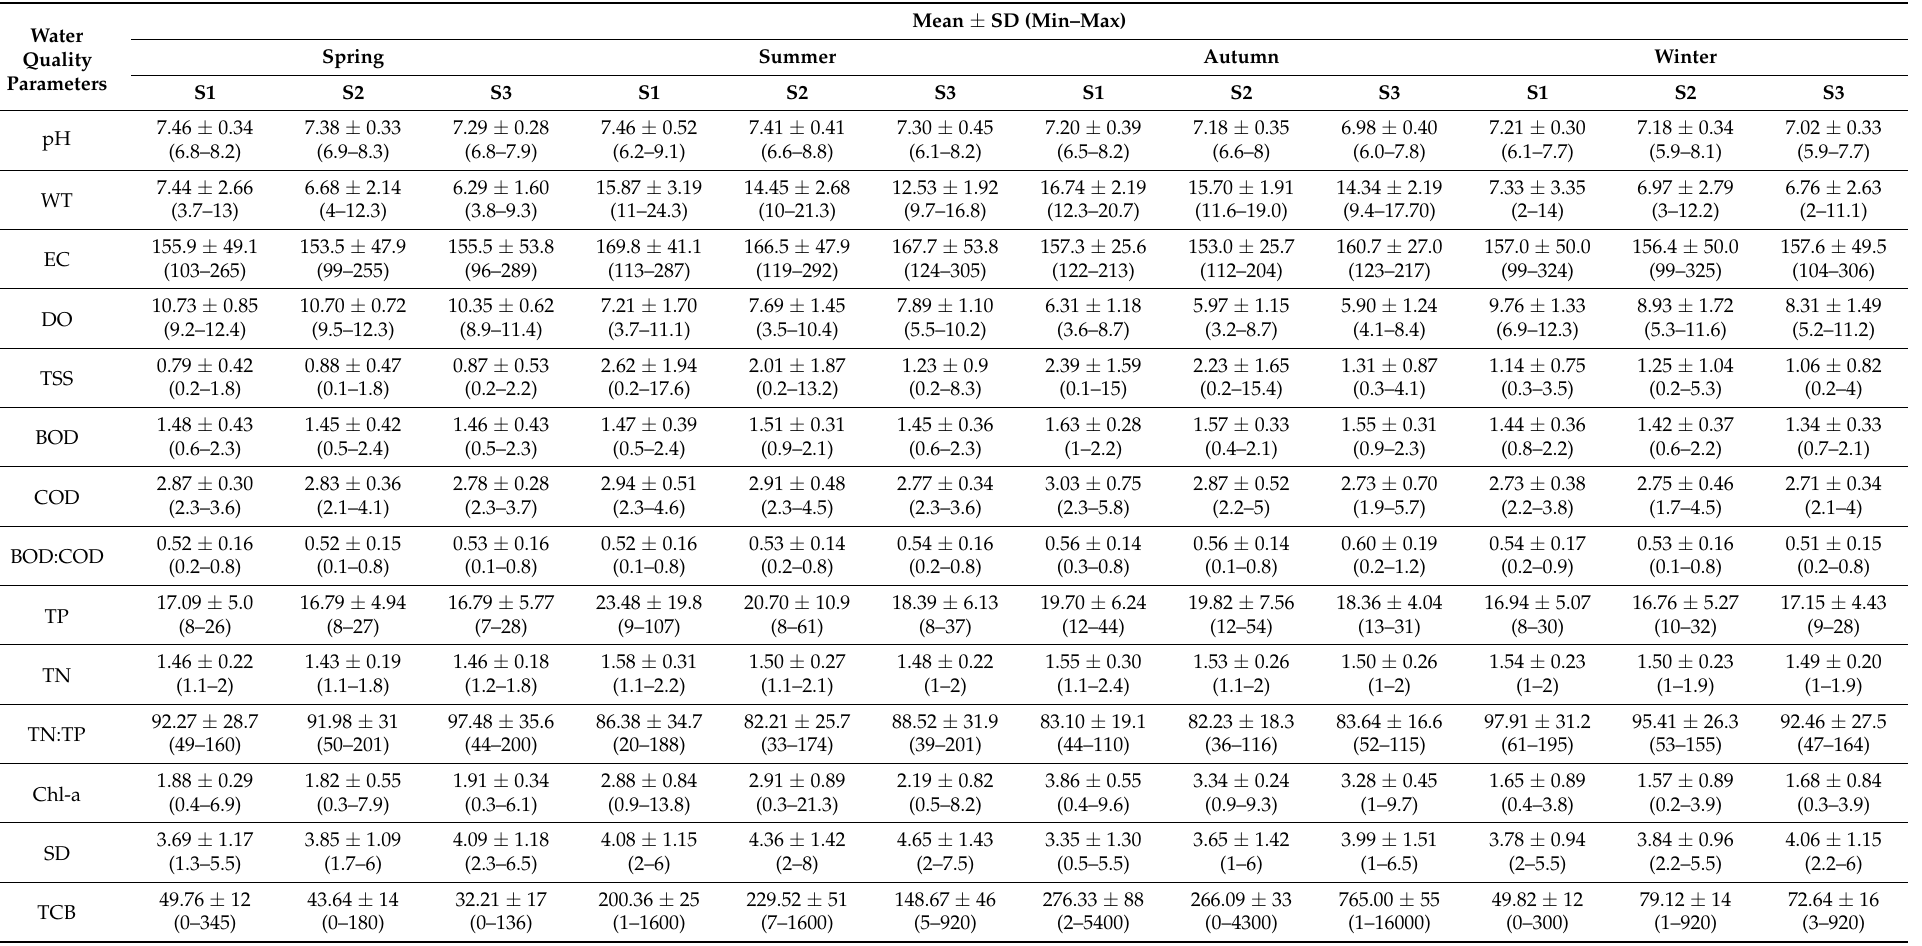
Table 1. Statistical summary of water quality parameters in Andong Reservoir. (units mgL − 1 , except pH, WT ( ◦ C), EC ( µ Scm − 1 ), TP ( µ gL − 1 ), CHL-a ( µ gL − 1 ), SD (m), and TCB (MPNmL − 100 ). WT: water temperature EC: electrical conductivity; DO: dissolved oxygen; TSS: total suspended solids; BOD: biological oxygen demand; COD: chemical oxygen